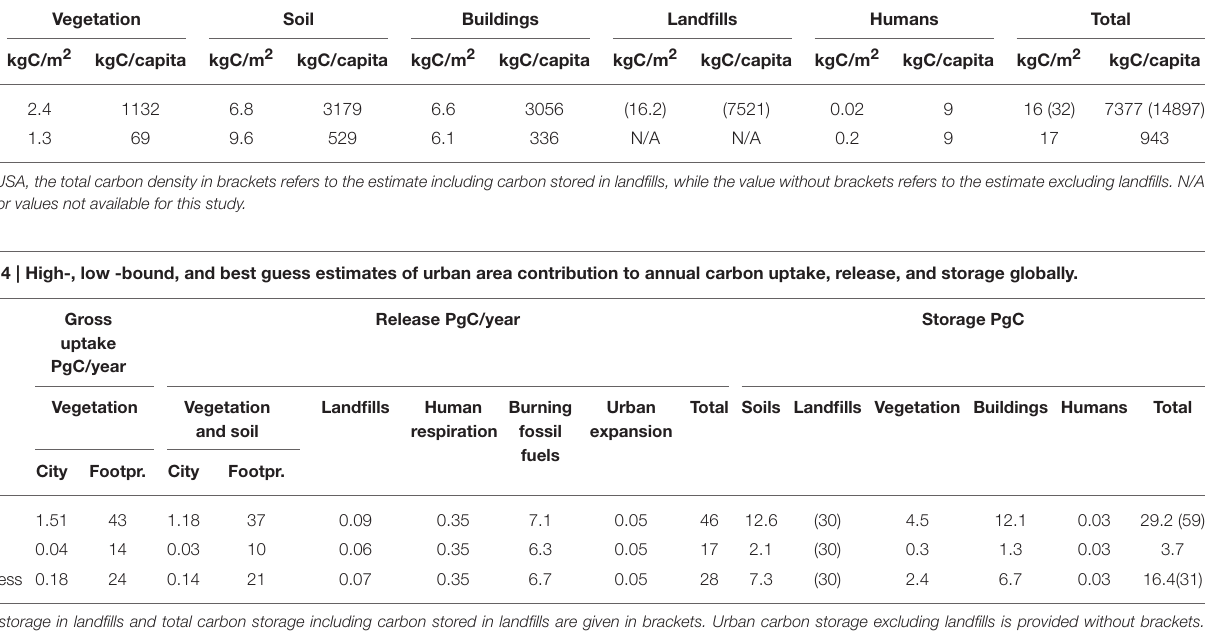
TABLE 3 | Average carbon density of urban pools based on studies from the USA and China used in calculations in this study. Vegetation Soil